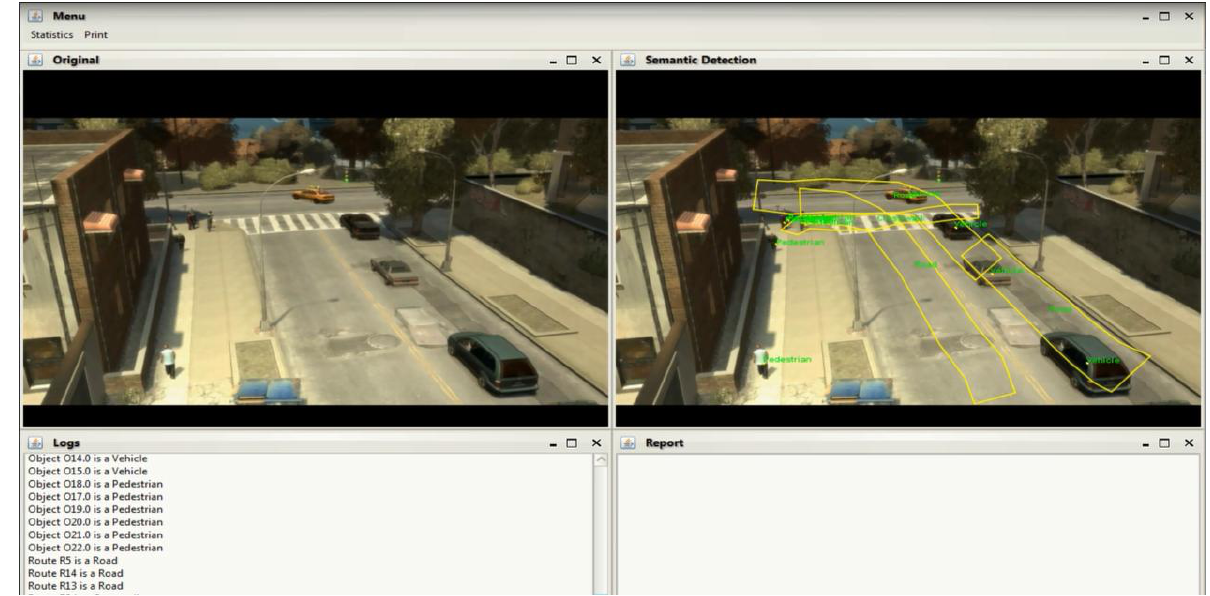
Figure 10. Example of a Semantic Engine’s learning